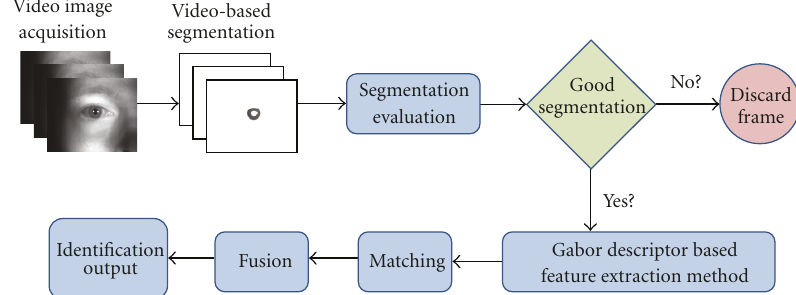
Figure 13: The Proposed video-based noncooperative iris recognition system.